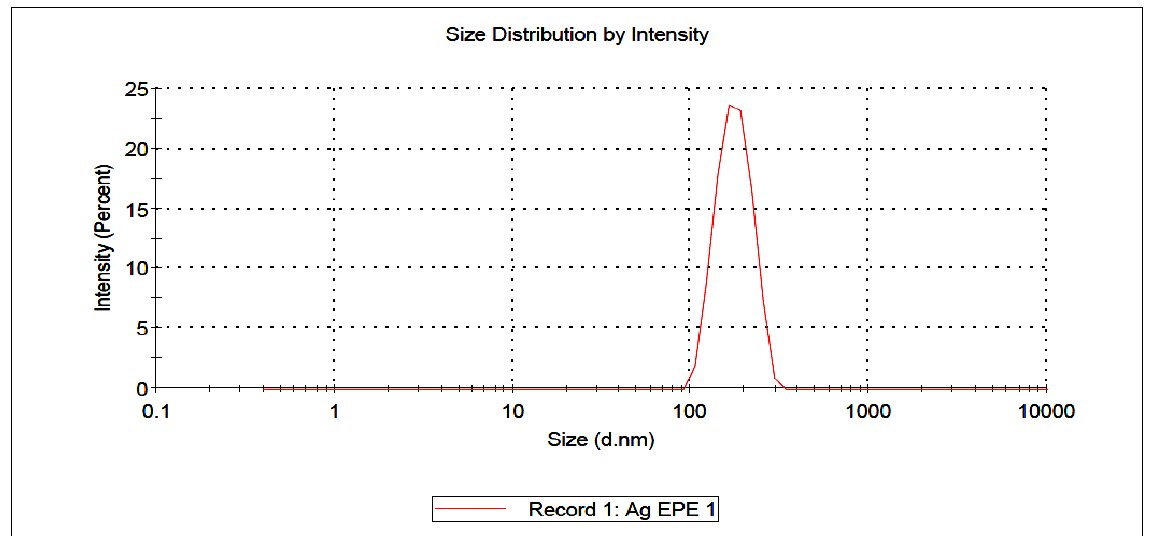
Figure 2. Size and charge of silver nanoparticles prepared using aqueous (AgWPE) extract as measured by zeta sizers.